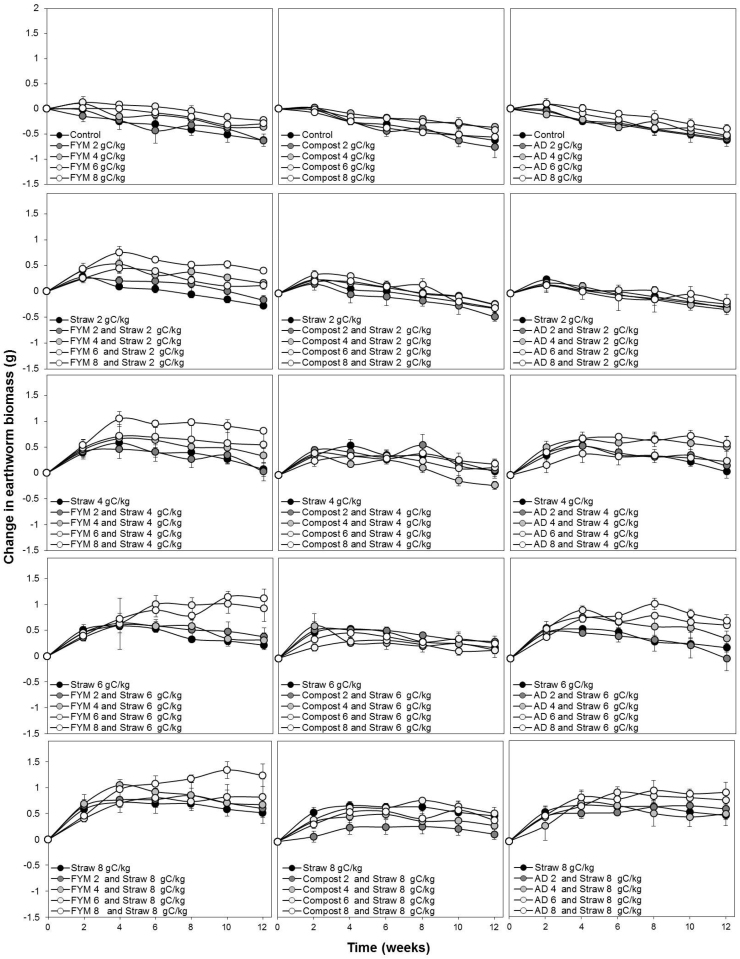
Change in Lumbricus terrestris biomass over the course of a 12 week experiment. Earthworms were incubated in bags containing soil amended with straw, manures (farmyard manure; FYM, compost, and anaerobic digestate; AD) and mixtures of straw and manure. Data presented is the mean change in biomass for four replicate earthworms since the start of the experiment. Error bars are standard errors of the mean.